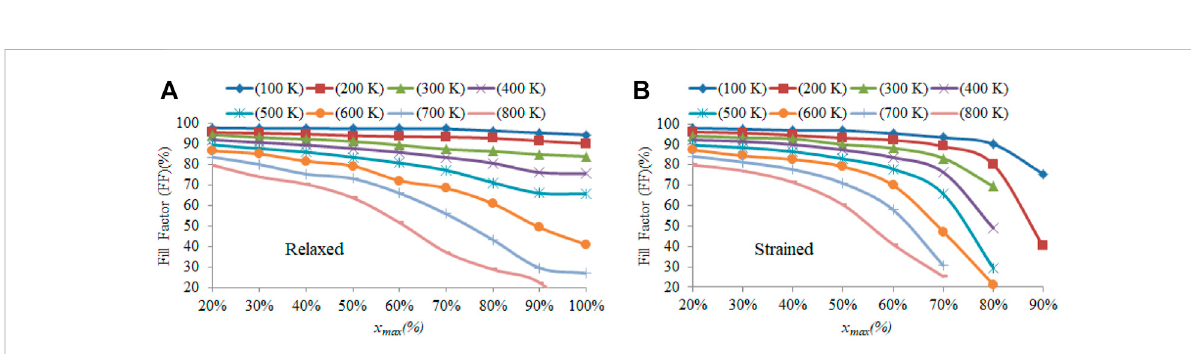
For the strained structures, the maximum ef fi ciency from high to low temperatures is linearly shifted toward low x max due to sharp dropping of V oc for high x max at high temperatures which reduces P max .